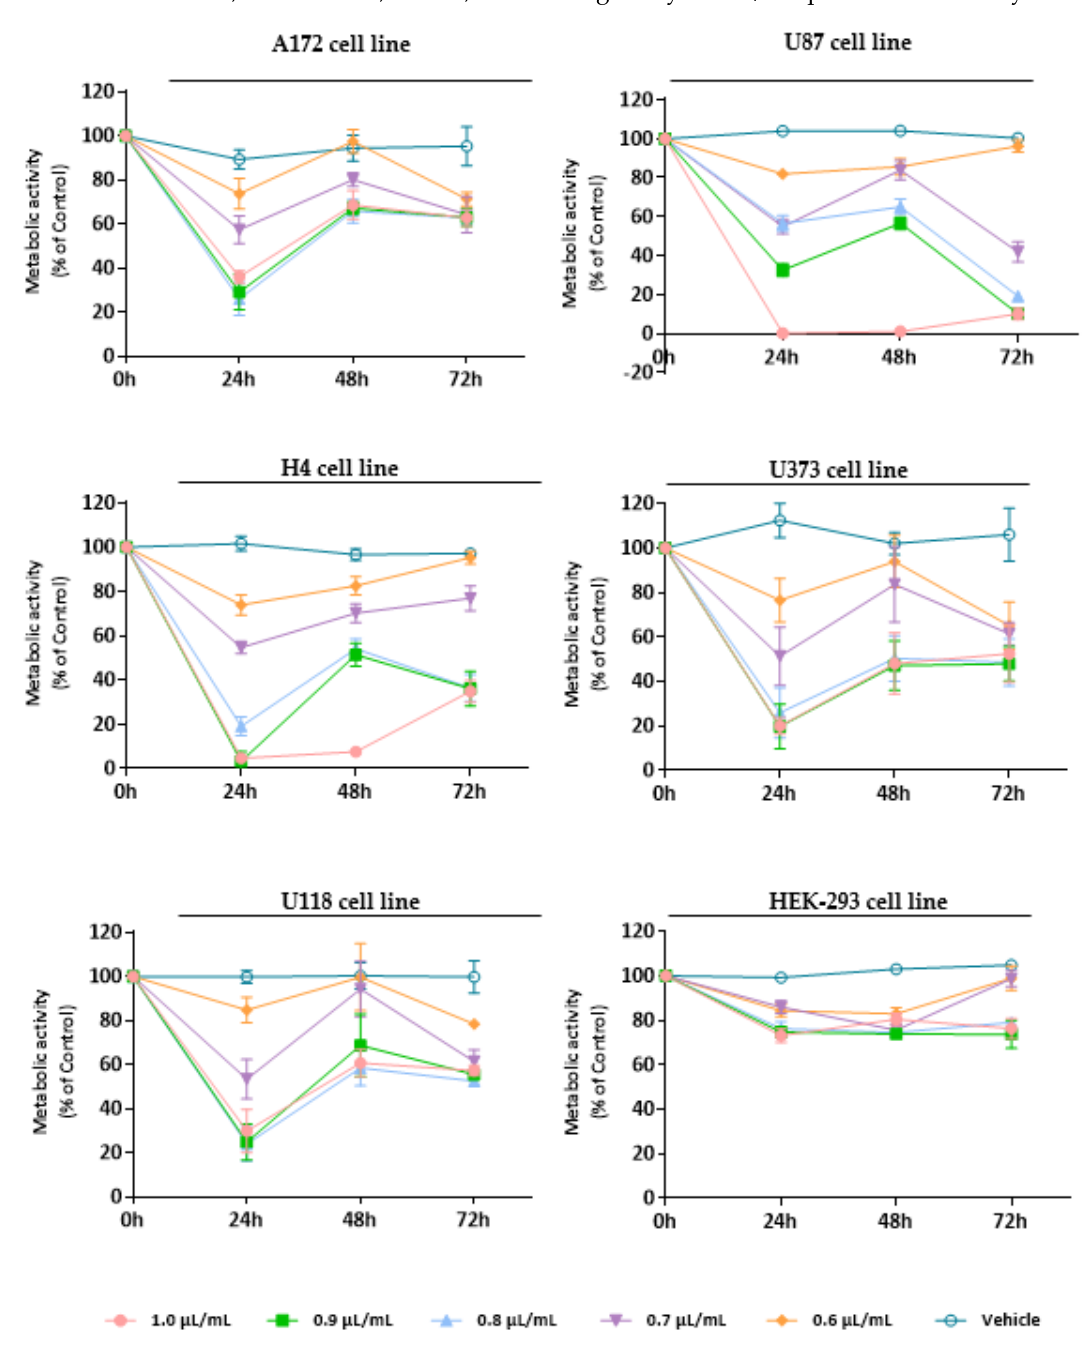
Figure 3. Cytotoxic effect of M. cervina EO against GB cells (A172, U87, H4, U373, and U118 cell lines) and non-tumoral cells (HEK-293 cell line). Cells were treated either with M. cervina EO (1.0, 0.9, 0.8, 0.7, and 0.6 µL/mL) or with the vehicle control (DMSO) for 24, 48, and 72 h. Cell viability (metabolic activity) was expressed as percentage of control (untreated cells). Results were presented as mean ± SD.